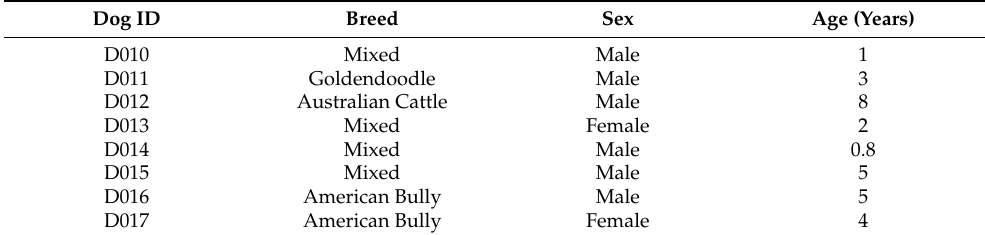
Table 1. Demographic information of dogs enrolled in the study.